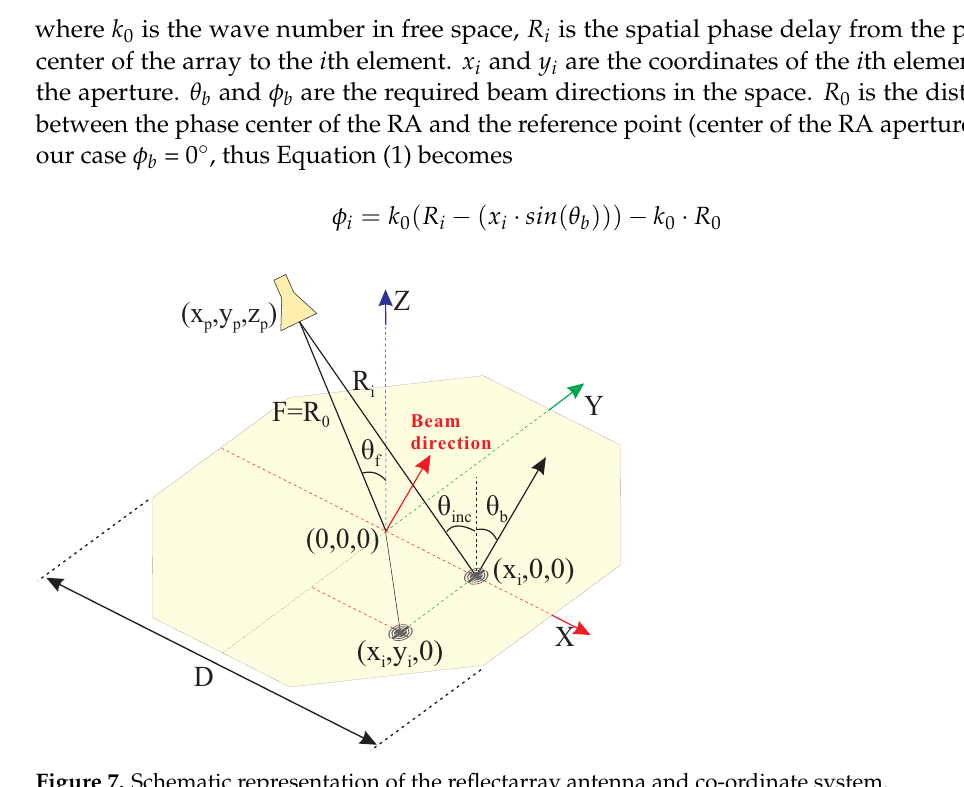
Figure 7. Schematic representation of the reflectarray antenna and co-ordinate